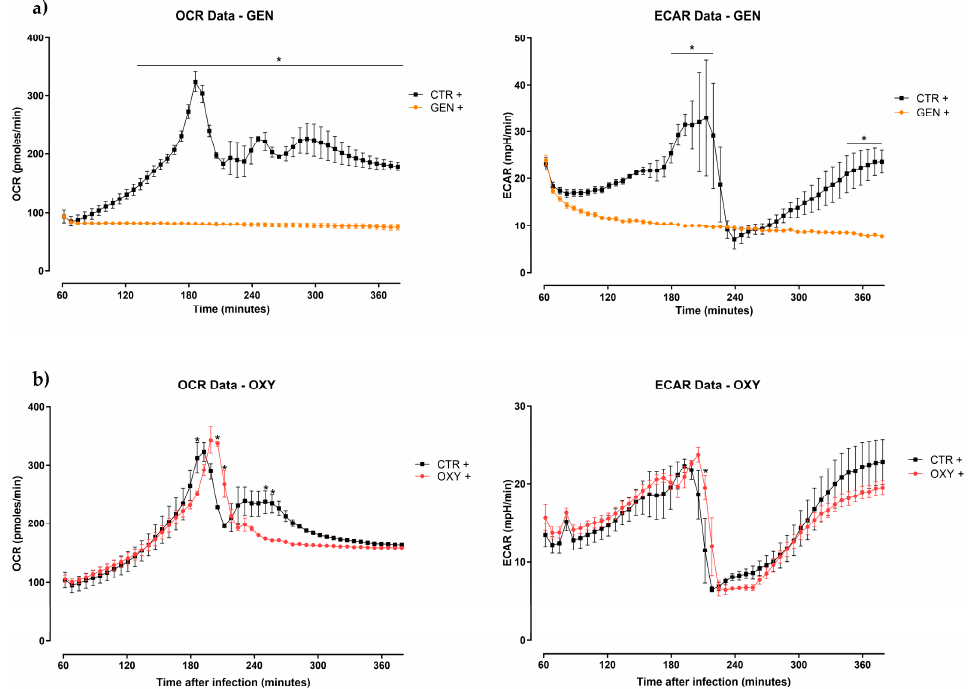
Figure 4. Oxygen consumption rate (OCR) and extracellular acidification rate (ECAR) of HD11 cells infected with Salmonella Enteritidis and treated with antibiotics (( a )—oxytetracycline (OXY) or ( b )—gentamicin (GEN)) for 6 h. The reads start from 60 min since, during the first hour, the Seahorse XFp Analyzer requires an internal calibration. Data are expressed as the mean ± SEM ( n = 3). Asterisks * indicate statistical significance with p ≤ 0.05.